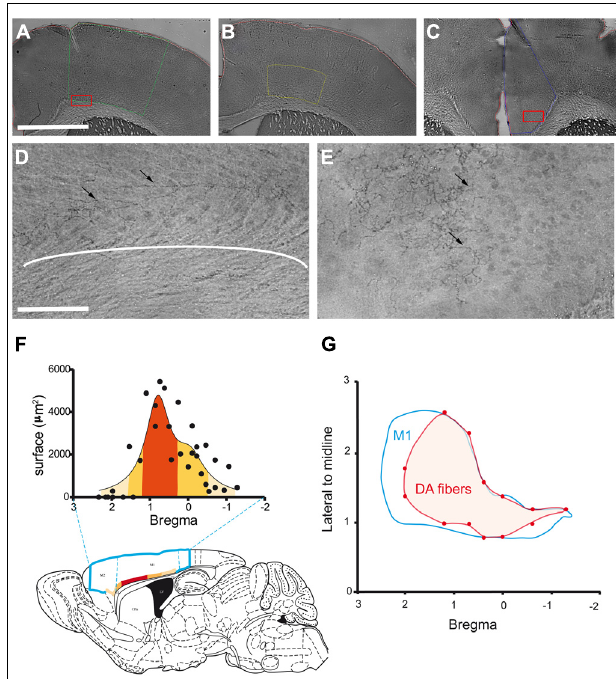
FIGURE 1 |Anatomical distribution of the dopaminergic terminals in M1. (A–C) Example of the delimitation of cortical regions: M1 ( A ; green line), M1 deepest layers ( B ; yellow line) and Cg ( C ; blue line). (D–E) Photomicrographs of DAT immunostained fibers (black arrows) in M1 deepest layers (D) and Cg (E) . (D) and (E) were obtained from higher magnification of the region contained in the red box shown in (A) and (C) , respectively. (F) Rostrocaudal repartition of DAT immunostained fibers in M1, the labeled superficies are represented for each level according to Bregma.The colors from light to dark orange code for the size of the labeled area, this color code is used to represent on the schematic sagittal section of mouse brain the distribution of these areas in the motor cortices (blue line delineates M2 and M1). (G) Distribution of the DAT labeled fibers at the surface of the cortex.The blue line represents delimitation of M1, the red area represents DAT immunostained fibers within M1. Scale bars represent 100 μ m (A–C) and 12.5 μ m (D–E)